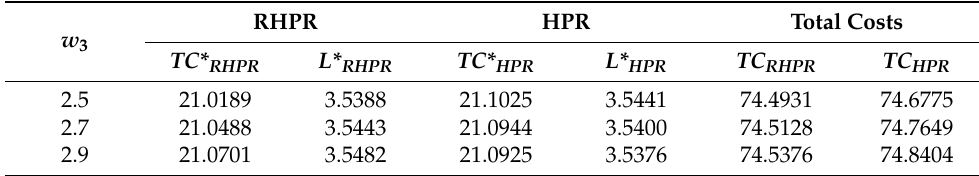
Table 1. Performance